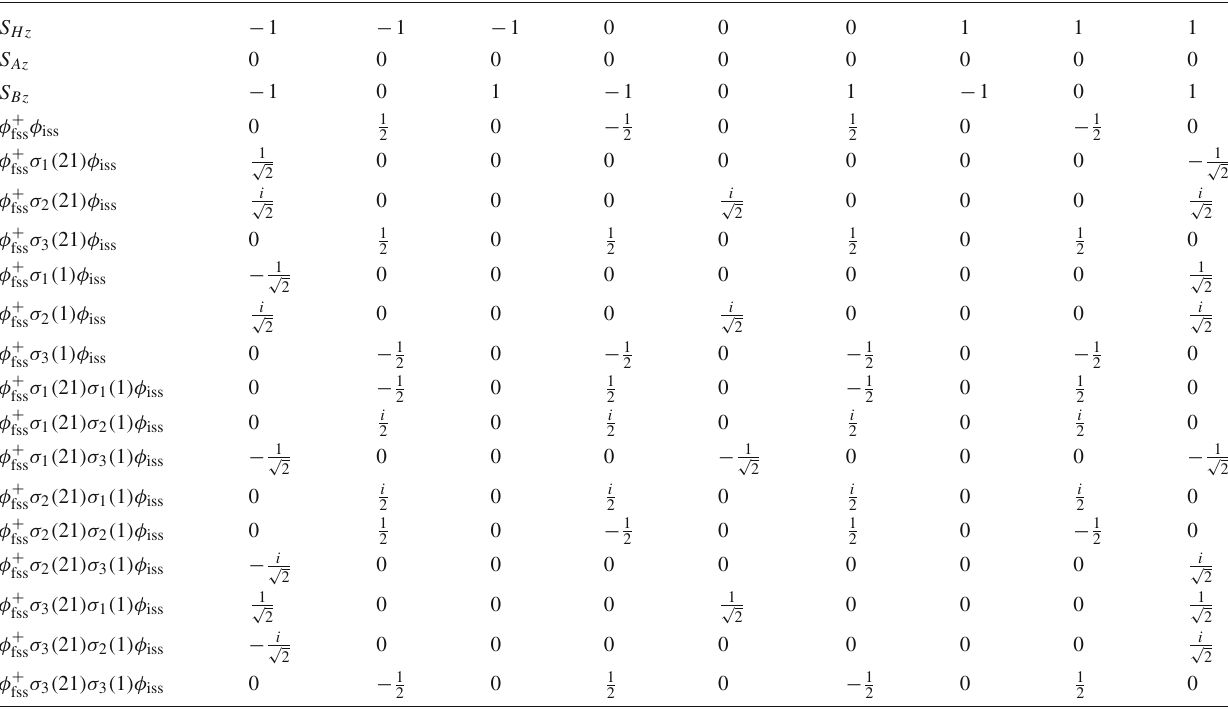
for A ( S A = 0 ) + B ( S B = 1 ) → H ( S H = 1 1 ¯ q 2 ¯ q 1